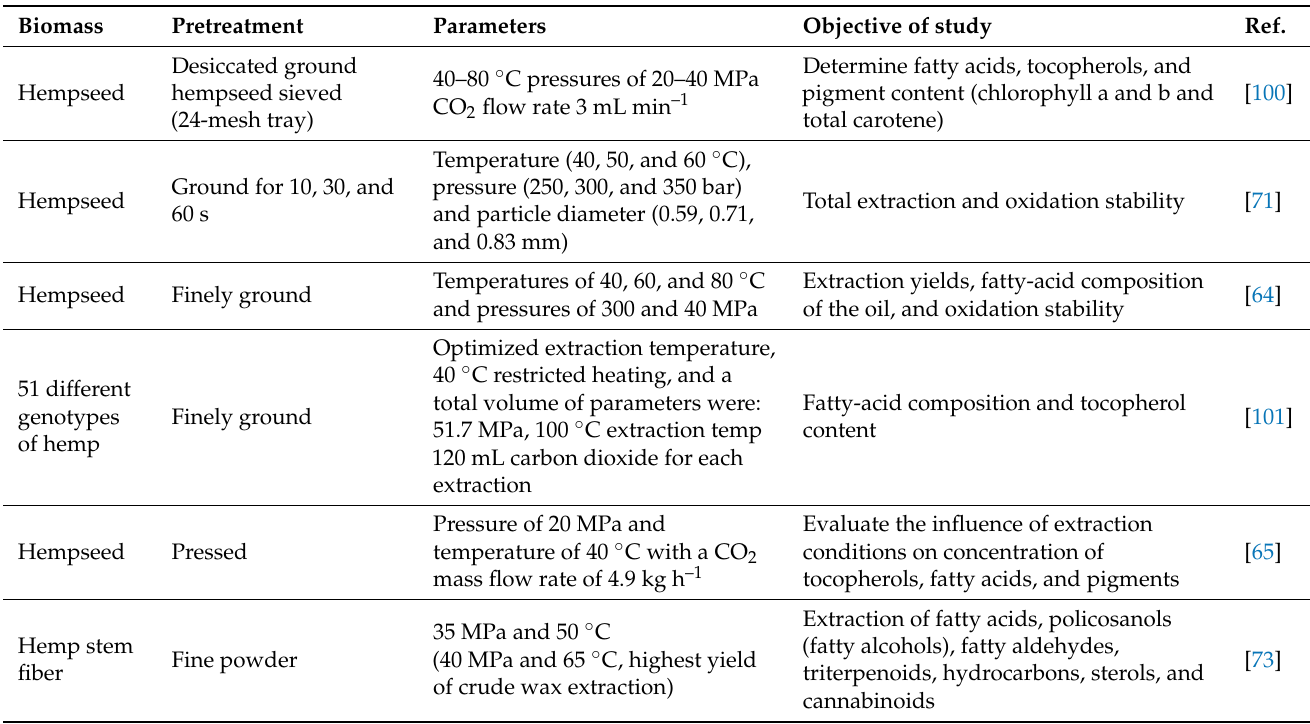
Table 6. Published studies on fatty-acids extraction using SC-CO 2 .